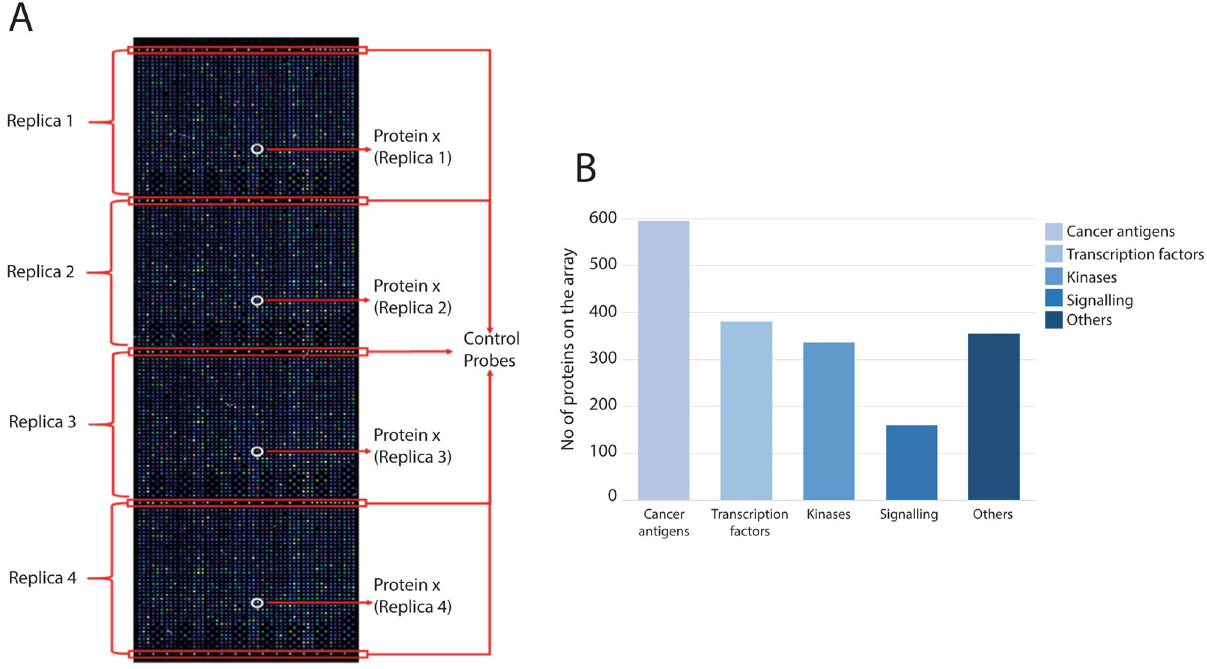
Figure 3. Immunome slide design and protein categories on the protein microarray. ( A ) The Immunome protein microarray consists of four identical subarrays, each containing 1631 different proteins in addition to 11 control proteins (BCCP, BSA, Cy3BSA, IgA, IgG, IgM, and four different control probes for the BCCP tag acting as negative controls). The control proteins are located between the subarrays. ( B ) The proteins spotted on the microarray represent different protein groups, such as cancer-associated antigens, transcription factors, kinases, and signaling proteins. The number of proteins in each category is shown. BCCP biotin carboxyl carrier protein, BSA bovine serum